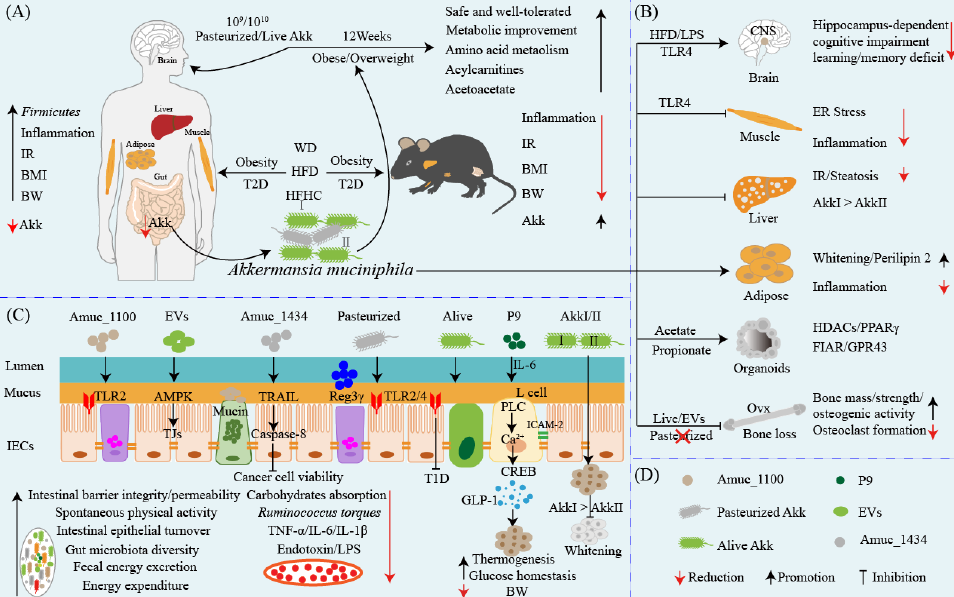
Figure 1. Cross-talk between Akkermansia muciniphila and multiple gut organs alleviates obesity and diabetes. ( A ) The characteristics of obesity and T2D and a short-term safety evaluation of Akk in humans with obesity. Individuals with obesity and diabetes have increased Firmicutes and de- creased Akk, accompanied by chronic low-grade inflammation, IR, and elevation of BMI and BW. Two clinical randomized, double-blind, placebo-controlled proof-of-concept and feasibility studies in overweight and obese human volunteers uncovered that oral supplementation with alive or pas- teurized 10 9 and 10 10 Akk for three months was safe and well tolerated. Alive or pasteurized Akk ameliorates insulin sensitivity, decreases insulinemia and plasma total cholesterol, and slightly re- duces body weight. Further plasma metabolome analysis revealed that short-term supplementation with alive or pasteurized Akk significantly modulates amino acid metabolism such as arginine, al- anine, tyrosine, phenylalanine, tryptophan, and glutathione metabolism, and increases acyl- carnitines and acetoacetate levels via induction of ketogenesis mediated by enhanced β -oxidation. ( B ) The beneficial metabolic effects of Akk on different organs and/or tissues. Akk improves neuro- degenerative impairment in the brain and ER stress and inflammation in muscle induced by HFD and/or LPS via the TLR-4 signaling pathway. Akk and its metabolites acetate and propionate regu- late the lipid metabolism of the liver, adipose tissue, and organoids and display genotype differ- ences. Alive Akk and EVs protect bone loss induced by Ovx via increasing bone mass, strengthening osteogenic activity, and inhibiting osteoclast formation, whereas pasteurized akk fails to do so. ( C ) Akk and its components impact intestinal metabolism and health. Alive Akk, pasteurized Akk, and outer membrane protein Amuc_1100 activate TLR2/4 to facilitate the secretion of mucins and ex- pression of TJ proteins to promote intestinal barrier function in obesity and T2D induced by WD, HFD, and HFHC. Furthermore, Akk also ameliorates intestinal barrier damage via inhibiting pro- inflammatory cytokines (including TNF- α, IL - 1β, and IL-6) and endotoxin/LPS production. For in- stance, EVs promote TJ expression by activating AMPK and Amuc_1434; upregulate cell cycle, p53 expression, and TRAIL-Caspase-8 pathway to promote apoptosis; and ultimately suppress cancer cell viability. Akk can increase thermogenesis by interacting with ICAM-2 and its secreted P9 pro- tein stimulates L cells to secrete GLP-1, which maintain glucose homeostasis mediated by IL-6. Akk also suppresses carbohydrate absorption and accelerates energy expenditure, spontaneous physical activity, and intestinal epithelial turnover. The genotypes of Akk impact the efficiency of its inhib- iting brown adipose tissue whitening and inflammation. ( D ) The forms of Akk and its outer mem- brane components. Abbreviations: BMI: body mass index; IR: insulin resistance; BW: body weight; WD: Western diet; HFD: high-fat diet; HFHC: high-fat high cholesterol; ovx: ovariectomy; T1D: type